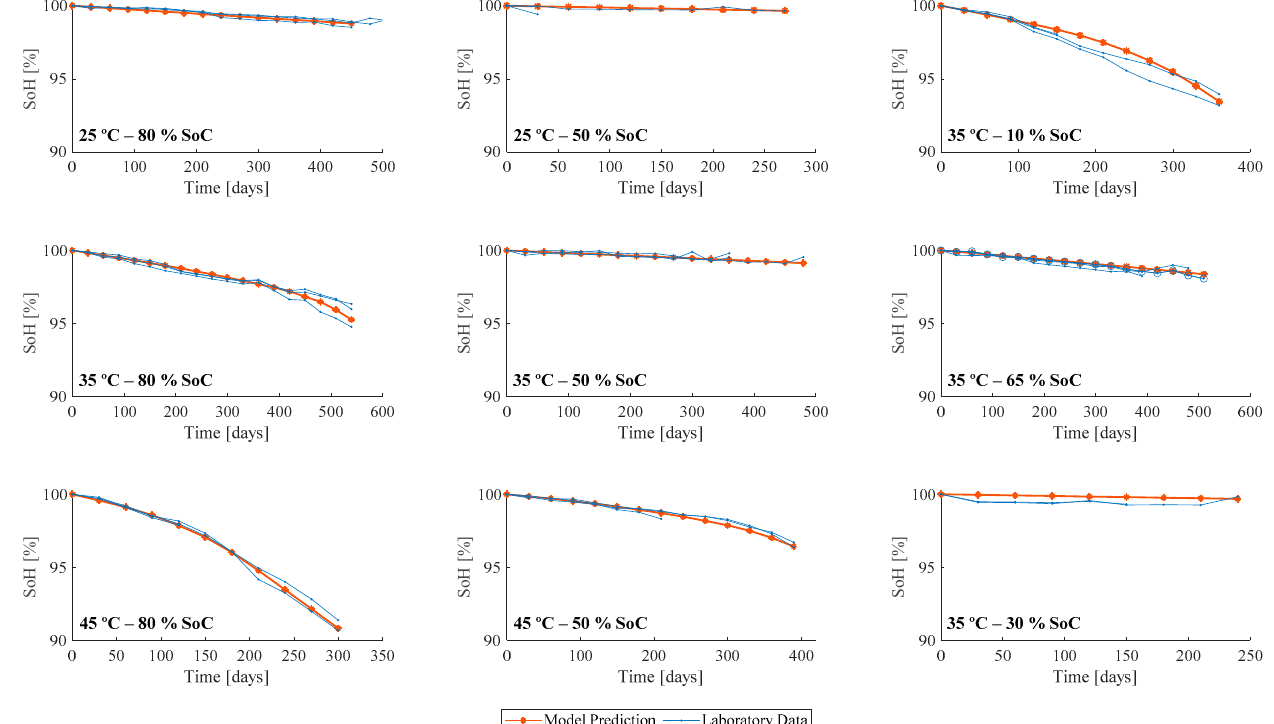
Figure 4. NMC laboratory data and model prediction.